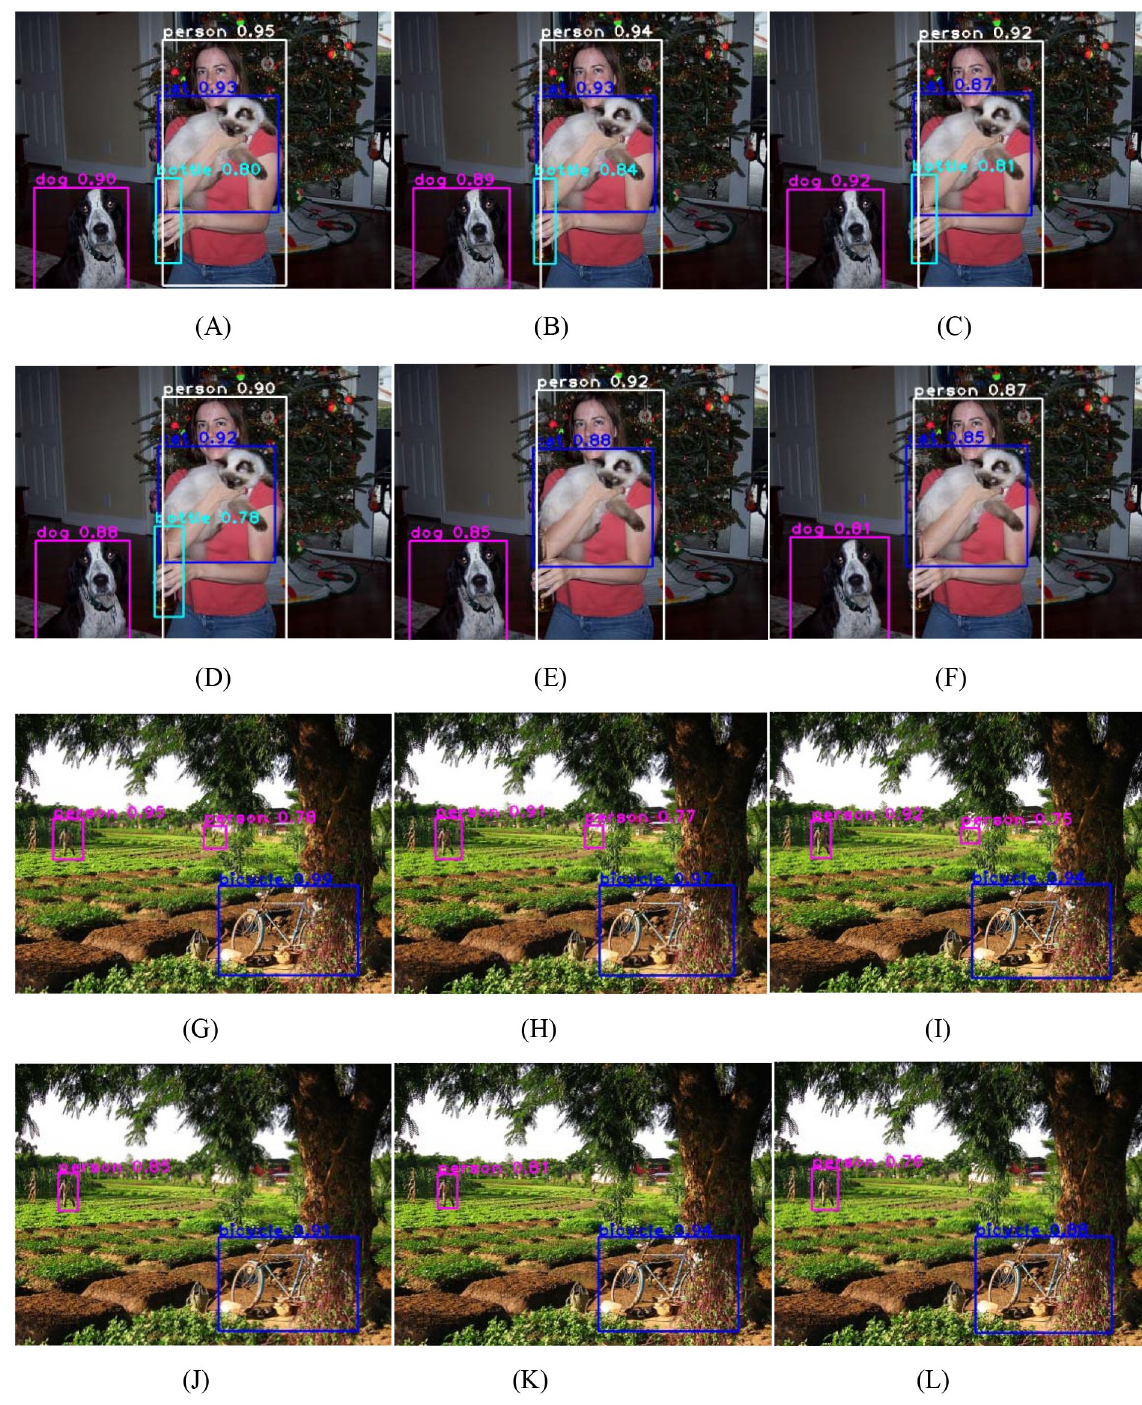
Fig 3. Object detection based on different lightweight networks.